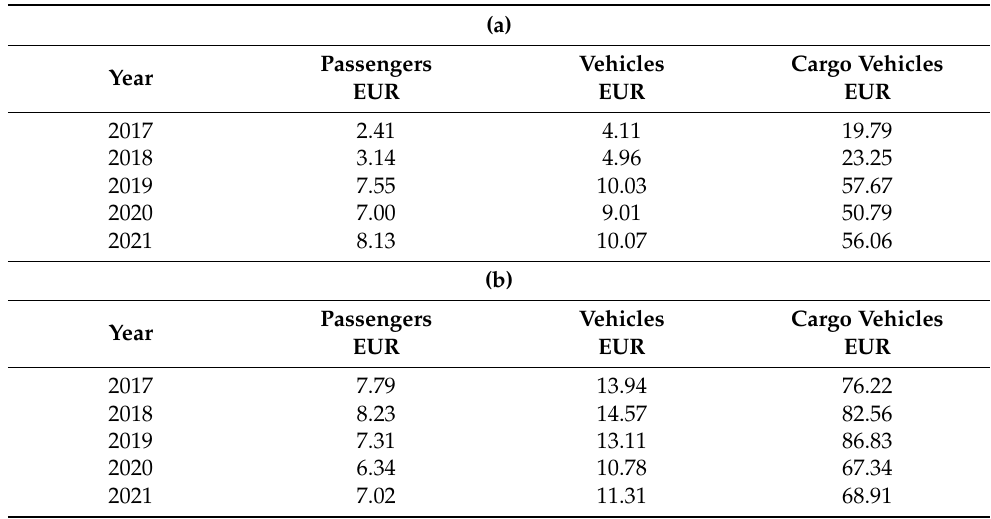
Table 10. (a) Additional fare cost for per transportation category for passenger ferries (Souda port). (b) Additional fare cost for per transportation category for passenger ferries (Heraklion port).